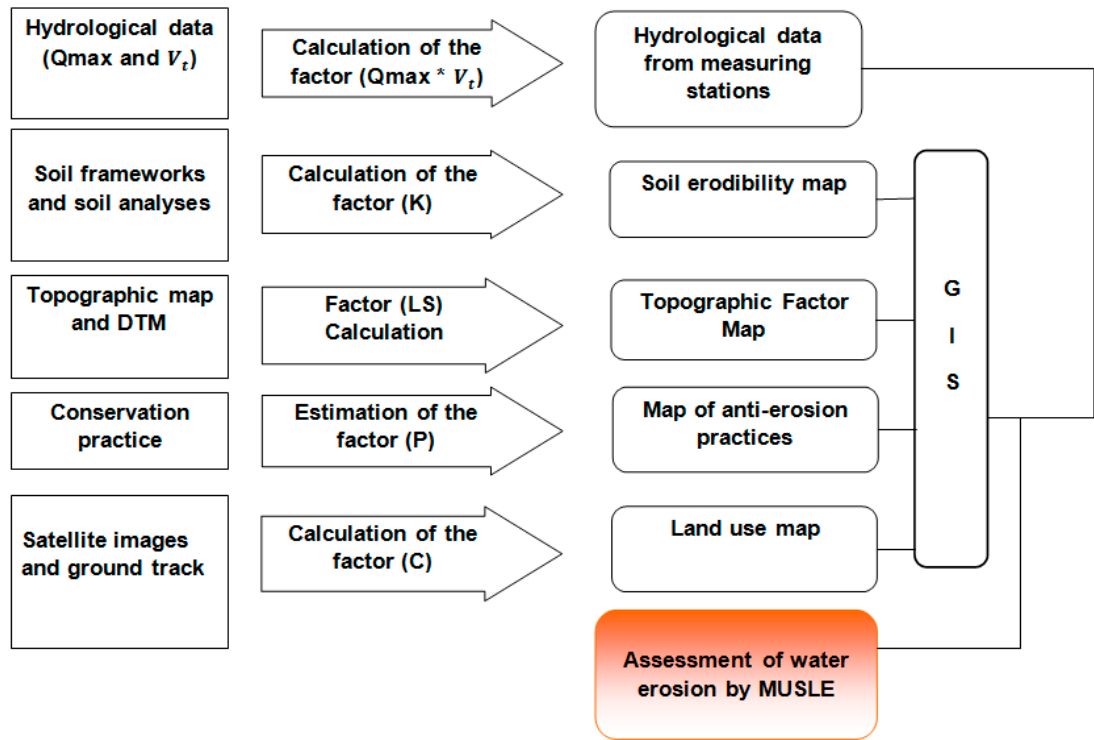
Figure 5. Methodology adopted for the assessment of erosion in the Bouregreg basin.